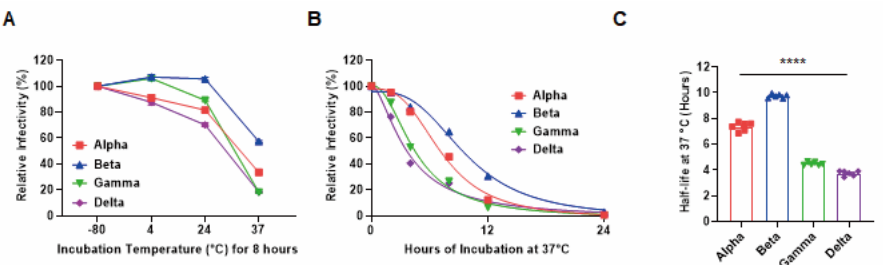
Figure 2. Different thermal stability of four SARS-CoV-2 variants. ( A ) The relative infectivity of each variant after incubation at 4, 24, or 37 °C for 8 h as evaluated via the focus-forming assay. ( B ) Nonlinear regression of the relative infectivity of each variant following prolonged incubation (2, 4, 8, 12, and 24 h) at physiological temperatures (37 °C). ( C ) Average half-life values for each variant at 37 °C. All error bars indicate the standard errors of the mean. Mean values for the half-life were compared using one-way ANOVA in GraphPad Prism 8.0 software. Statistical significance was set at p < 0.05 (****, p < 0.0001).